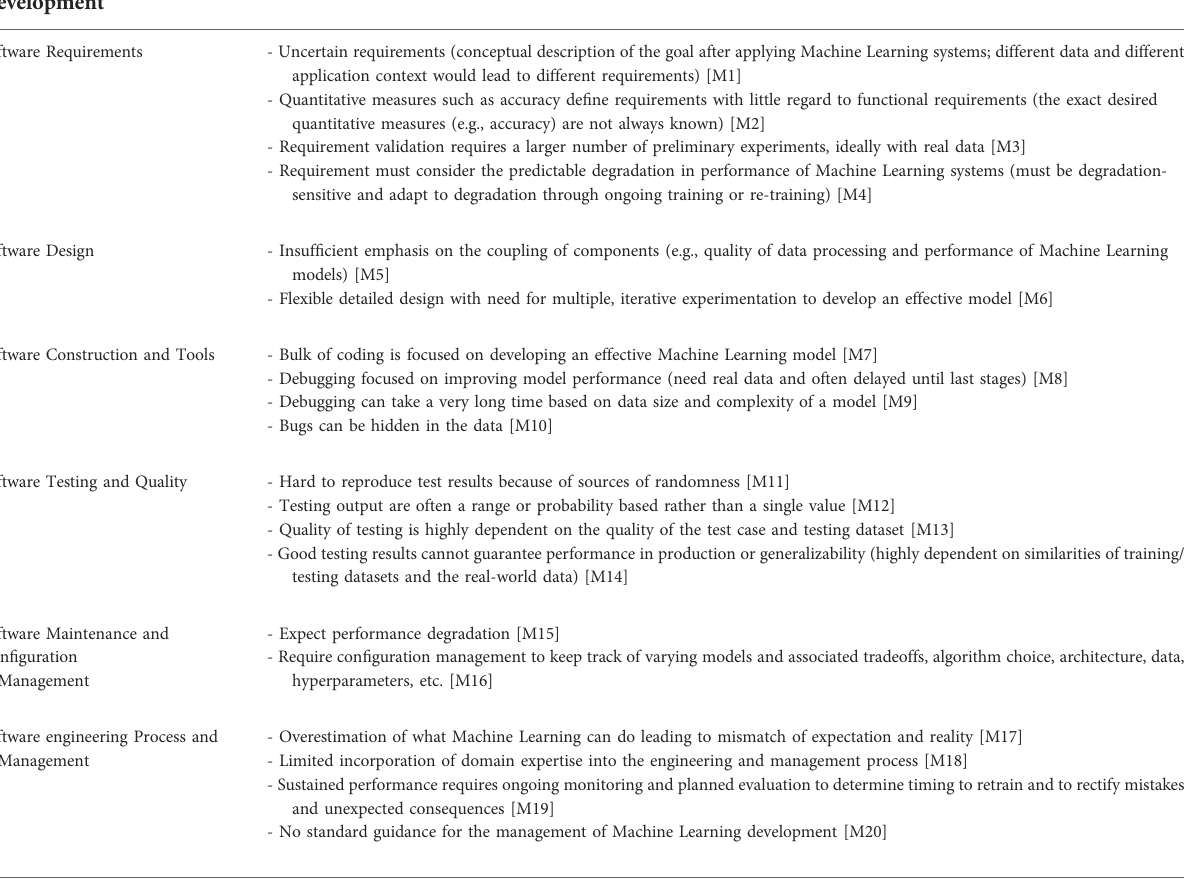
TABLE 3 Summary of challenges associated with machine learning life cycle